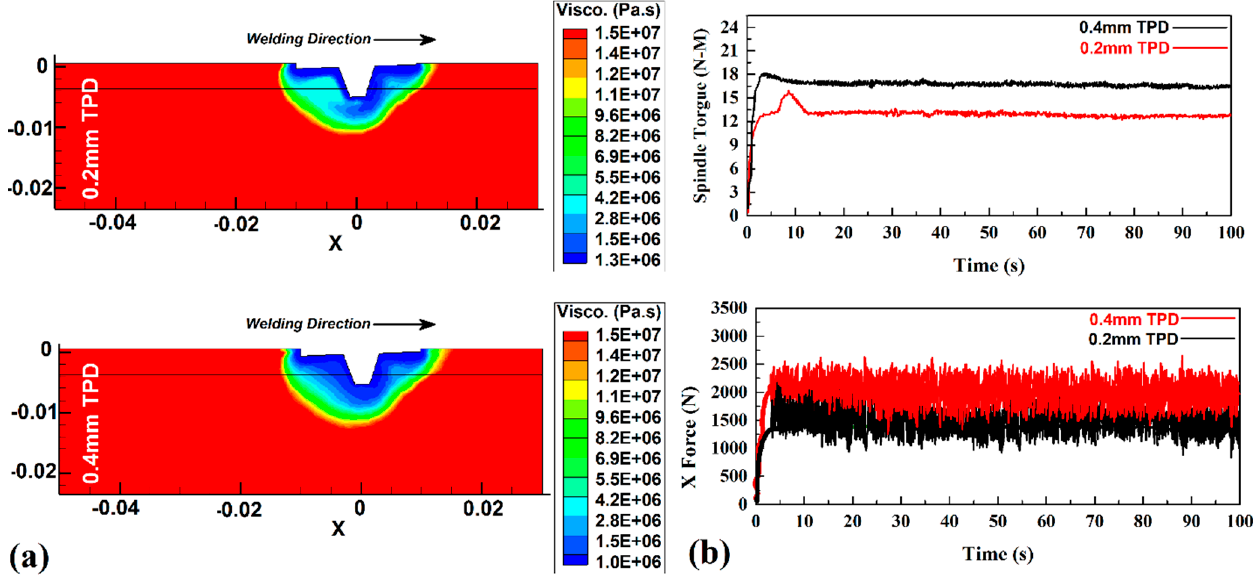
Figure 5. ( a ) Simulation results of internal viscosity changes at 0.2 mm and 0.4 mm TPD. ( b ) Force analysis of the FSW tool at 0.2 mm and 0.4 mm.